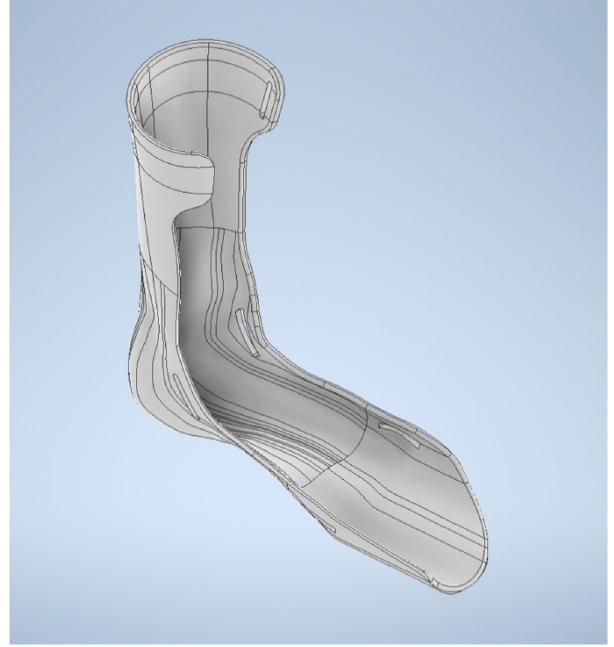
Figure 3. Generated AFO after scanning, design, and modification.